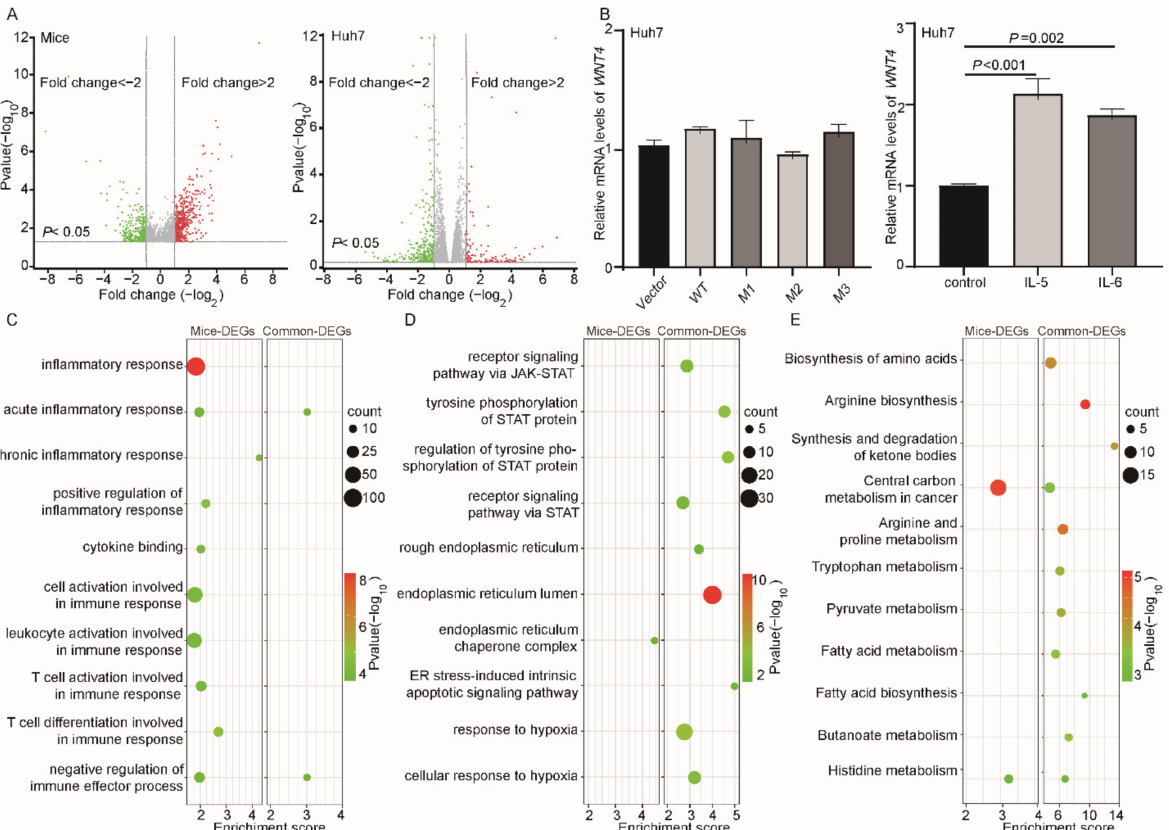
Figure 5. Functional analysis of HBV preS mutations. ( A ) ( left ) Differential expressed genes (DEGs) in preS1/preS2/S mutant-injected SB mice vs. WT preS1/preS2/S-injected SB mice ( n = 1377). ( right ) DEGs in HBV preS1/preS2/S mutant-expressing Huh7 cells vs. HBV preS1/preS2/S WT-expressing Huh7 cells ( n = 440). p values and fold changes were calculated by nbinom Test. ( B ) The mRNA levels of WNT4 in Huh7 cells which is detected by qRT-PCR. ( left ) Ectopic expression of HBV preS1/preS2/S mutants has no direct effect on the mRNA expression of WNT4 . ( right ) Effects of IL-5 and IL-6 (100 ng/mL, 1 h), two preS1/preS2/S mutant-induced cytokines, on the mRNA expression of WNT4 . p values were calculated by Student’s t -test. ( C ) Most of the inflammation- and immune response-related GO terms were significantly enriched in DEGs that were identified specifically in SB mice (mice-DEGs) rather than in DEGs identified both in SB mice and Huh7 cells (common- DEGs). ( D ) ER stress-, STAT pathway-, and hypoxia-related GO terms were significantly enriched in common-DEGs, rather than in the mice-DEGs. ( E ) Most of the KEGG identified metabolism-related pathways significantly enriched in common-DEGs, rather than in the